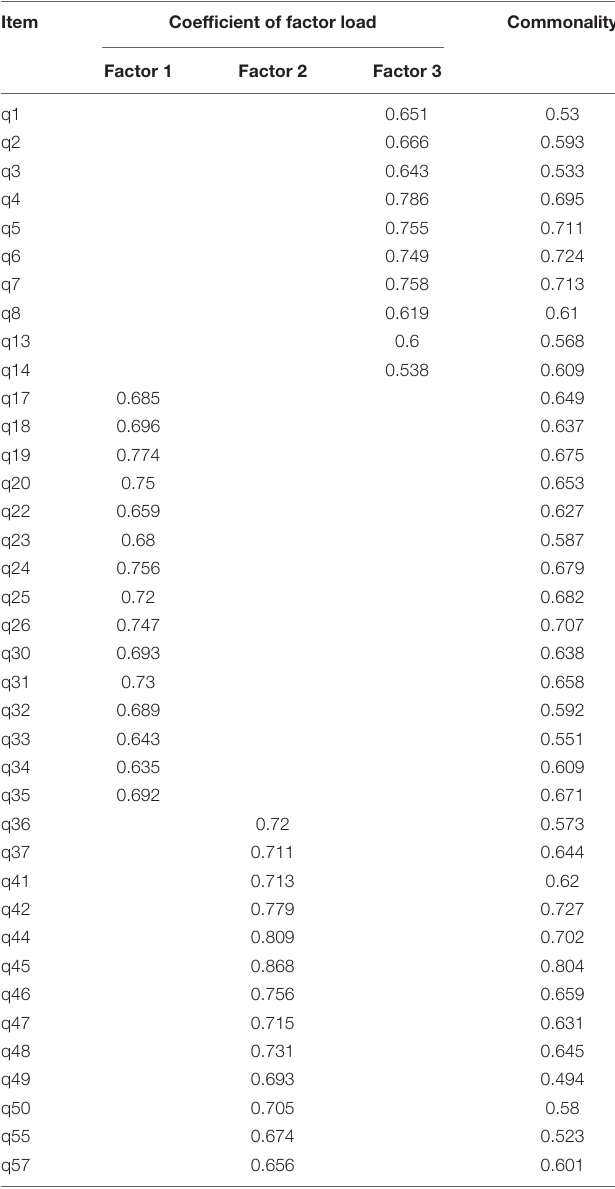
TABLE 2 | Exploratory factor analysis of the scale of hotline counselors’ competence ( N = 343). Item Coefficient of factor